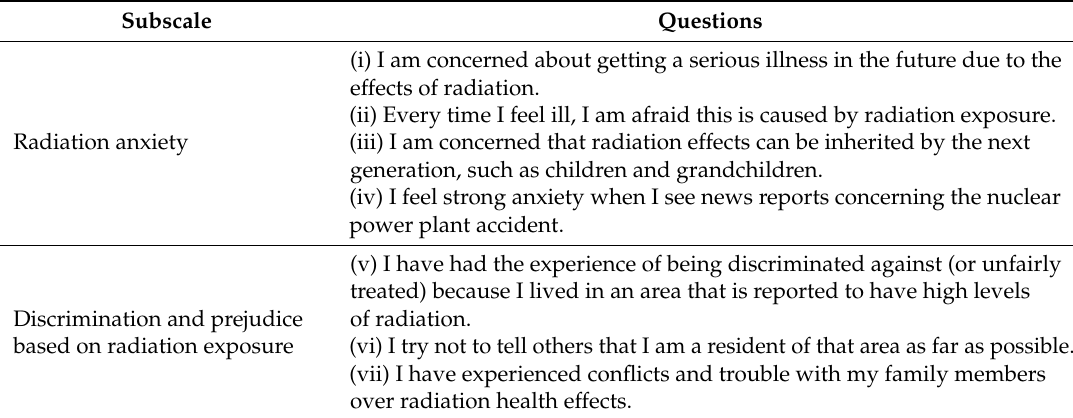
Table 1. Construction of a radiation anxiety scale